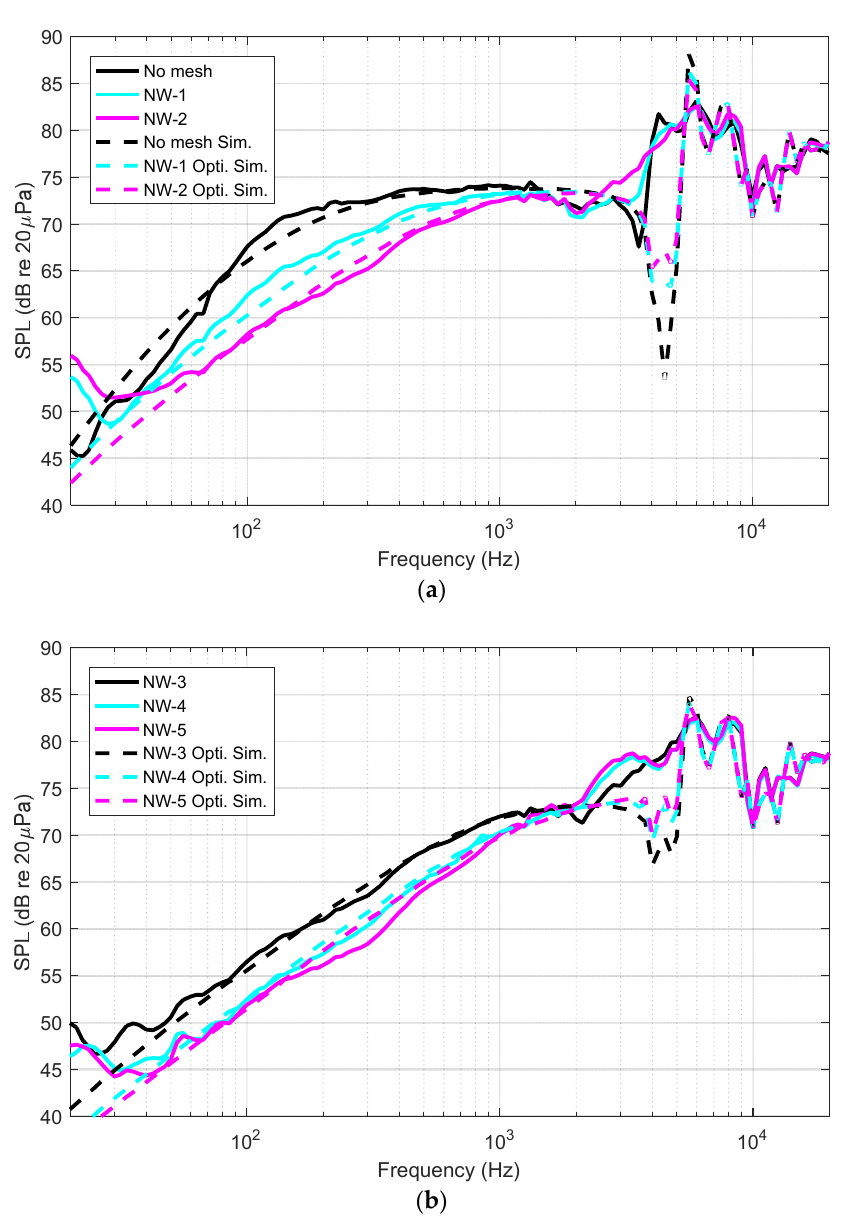
Figure 10. ( a ) Measured and simulated frequency responses of microspeaker without and with non-woven ventilation cloths (NW-1 to NW-2) and ( b ) Measured and simulated frequency responses of microspeaker with non-woven ventilation cloths (NW-3 to NW-5).